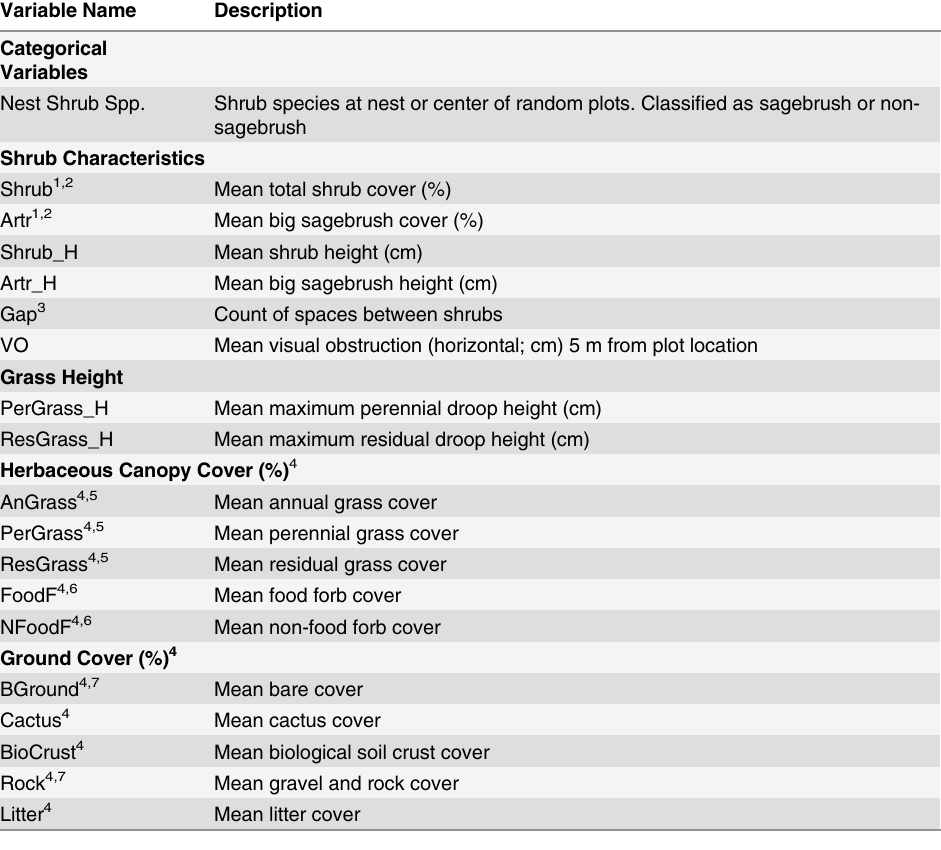
Table 2. Descriptions of microhabitat variables used to evaluate selection, availability (random-ran- dom), and nest success of sage-grouse. Data were collected at 928 sage-grouse nests and 819 random locations in in 5 study areas in Wyoming, USA, 2008 –